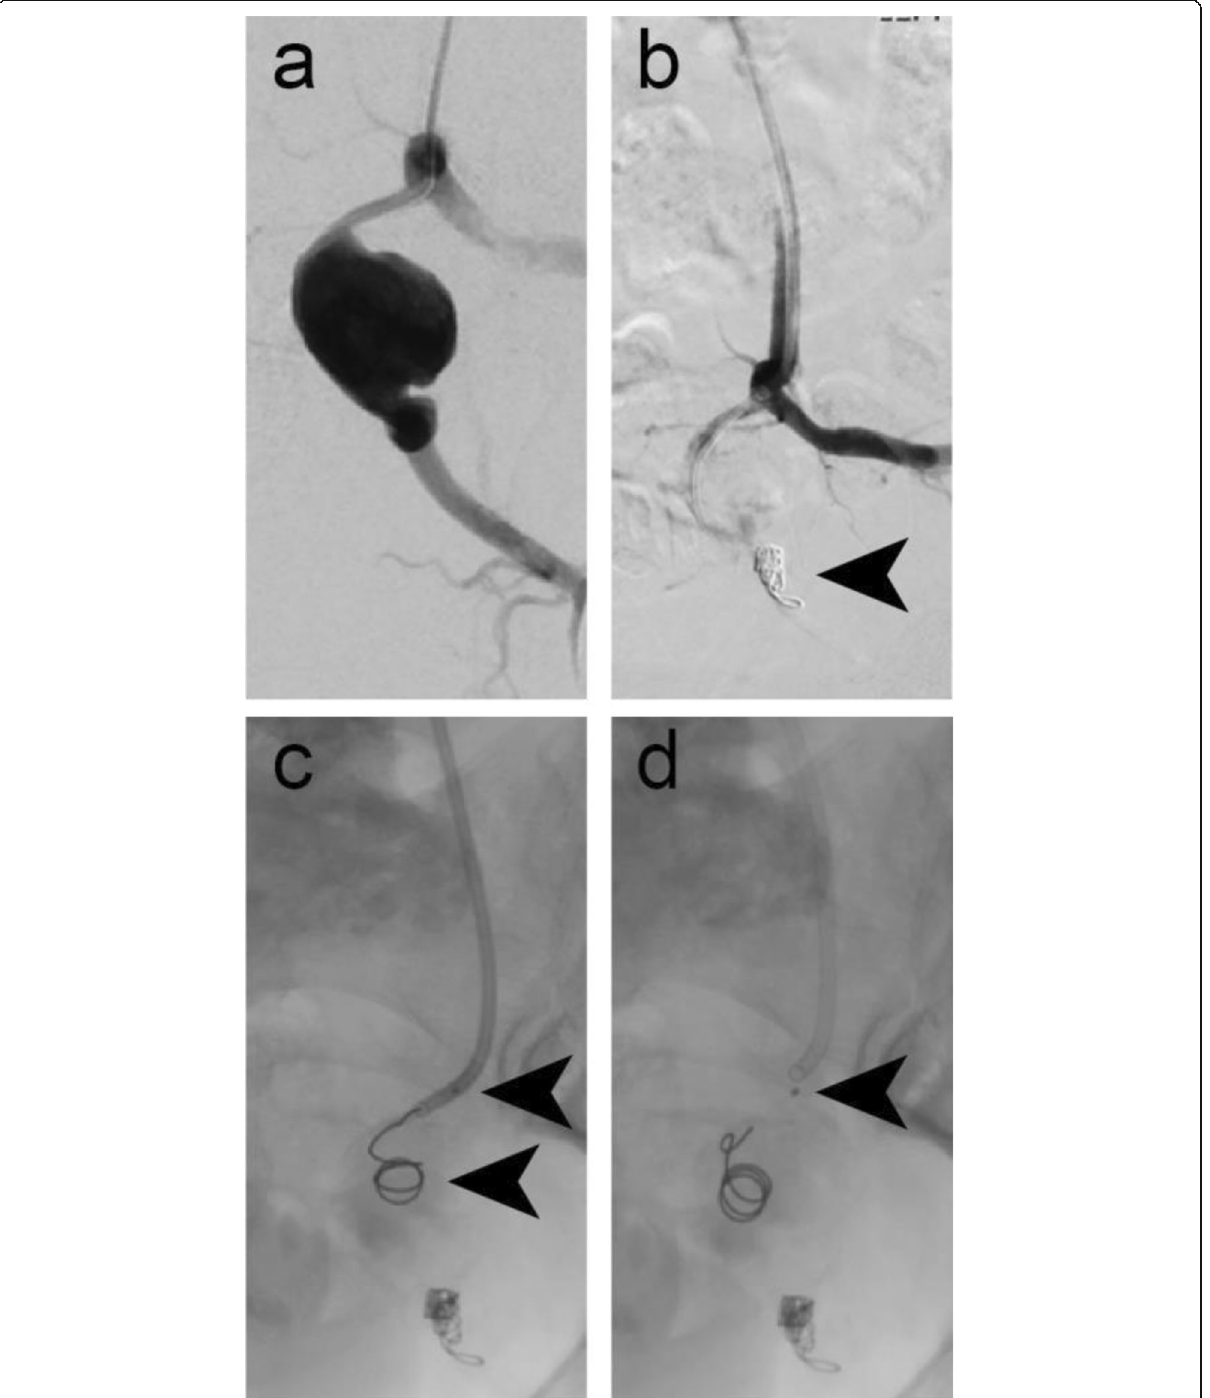
Fig. 5 Case 5. a Pre-embolisation DSA imaging of the left inferior gluteal artery aneurysm. b Microcoils were used for vessel embolisation distal to the aneurysm sac. c Intraprocedural DSA imaging showing the anchor coil deployed into the vessel, but immediately prior to deploying a 6 mm diameter shape memory polymer plug into the 5 mm diameter left inferior gluteal artery. Arrows indicate the anchor coil and proximal marker. Shape memory polymer is radiolucent but is between the anchor coil and proximal marker. d Intraprocedural DSA imaging immediately following deployment of the plug. Arrow indicates the proximal